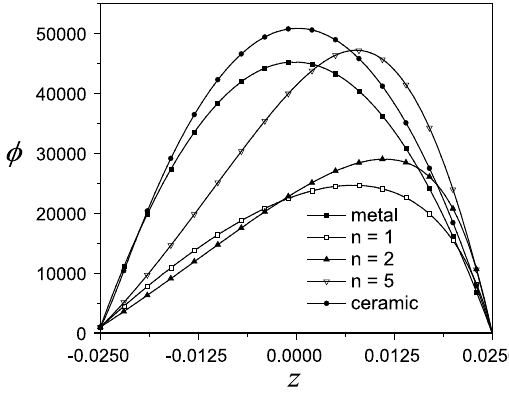
Fig. 8. Distribution of the electric potential φ along z -axis for the clamped supported FGPM cylindrical shell with different n ( q = 1 MPa, T 1 = 200 , T 2 = 0 , a = 1 m, L = 4 m, a/h = 20 , φ 1 = 1000 , φ 2 = 0 ).